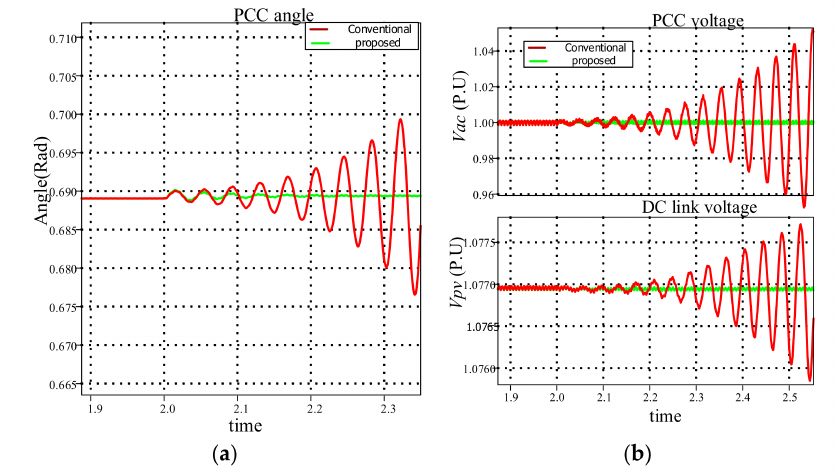
Figure 14. ( a ) grid angle and ( b ) v dc and v cd response when BW_PLL change from 5 Hz to 25